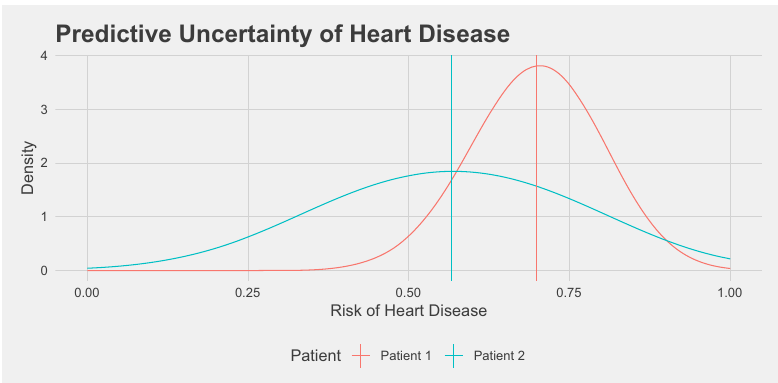
Fig. 1 Predictive uncertainty for the risk of heart disease in two patients. These distributions of risks over models were generated by randomly bootstrapping 1000 datasets from the Heart Disease UCI dataset 19 and training logistic regression models on each dataset. These distributions are the range of risks from this class of model assigned to these patients when they occurred in the test set, and the mean risk from the full dataset are shown as vertical lines. Despite the fact that both patients have similar mean risks for heart disease, we may be more inclined to trust the predictions for patient 1 given the lower amount of uncertainty associated with that